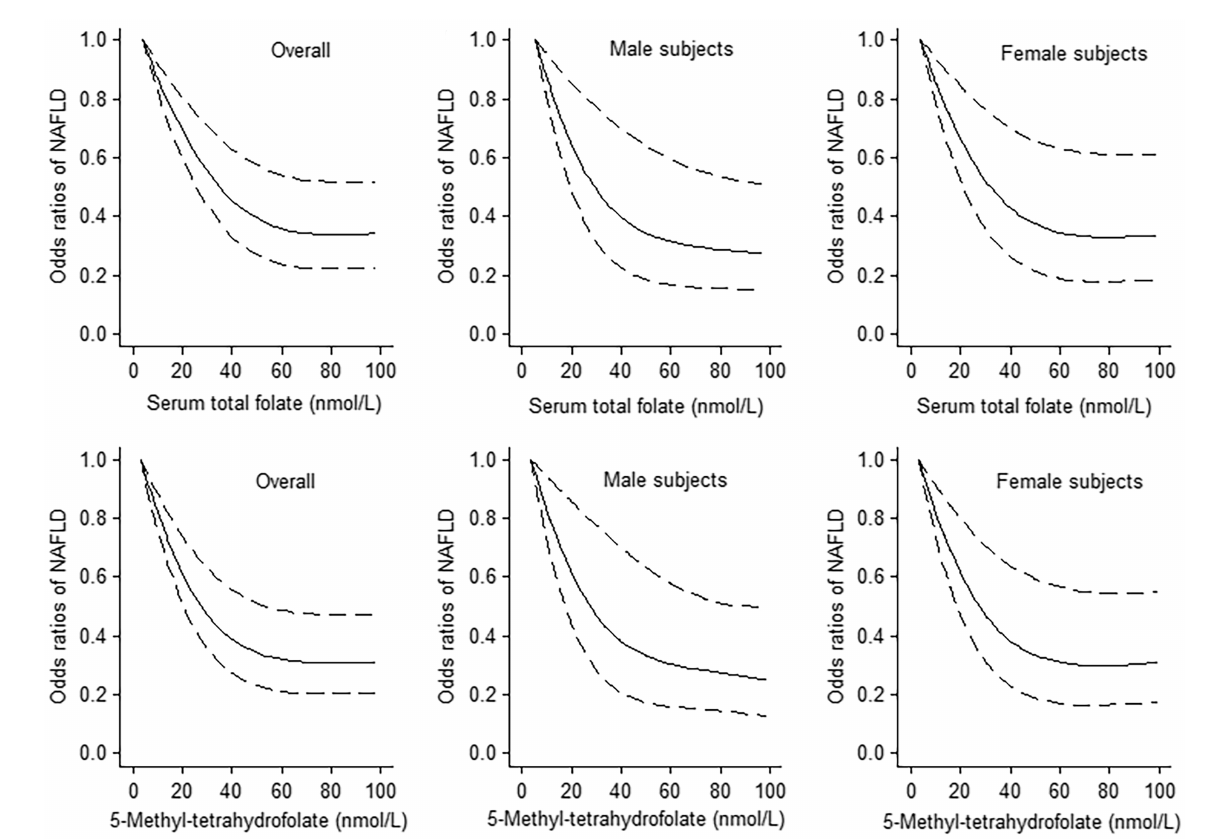
FIGURE 2 The dose–response analyses between serum total folate and 5-Methyltetrahydrofolate levels with non-alcoholic fatty liver disease (NAFLD) using the restricted cubic spline. The middle line and upper and lower line represent the estimated odds ratios and its 95% confidence interval, respectively. The lowest values of serum total folate and 5-Methyltetrahydrofolate levels were used as reference.